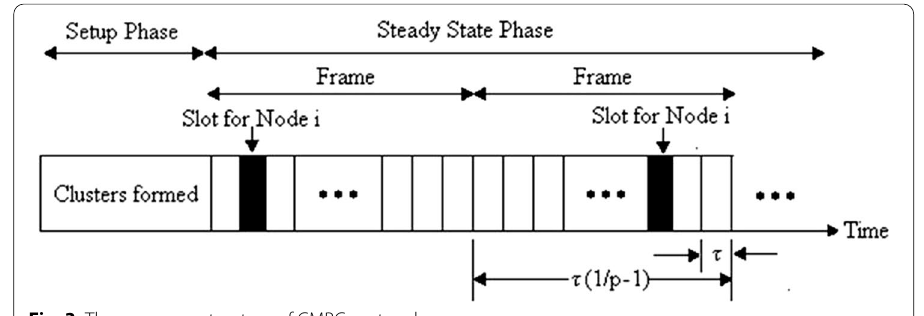
Fig. 3 The sequence structure of CMBC